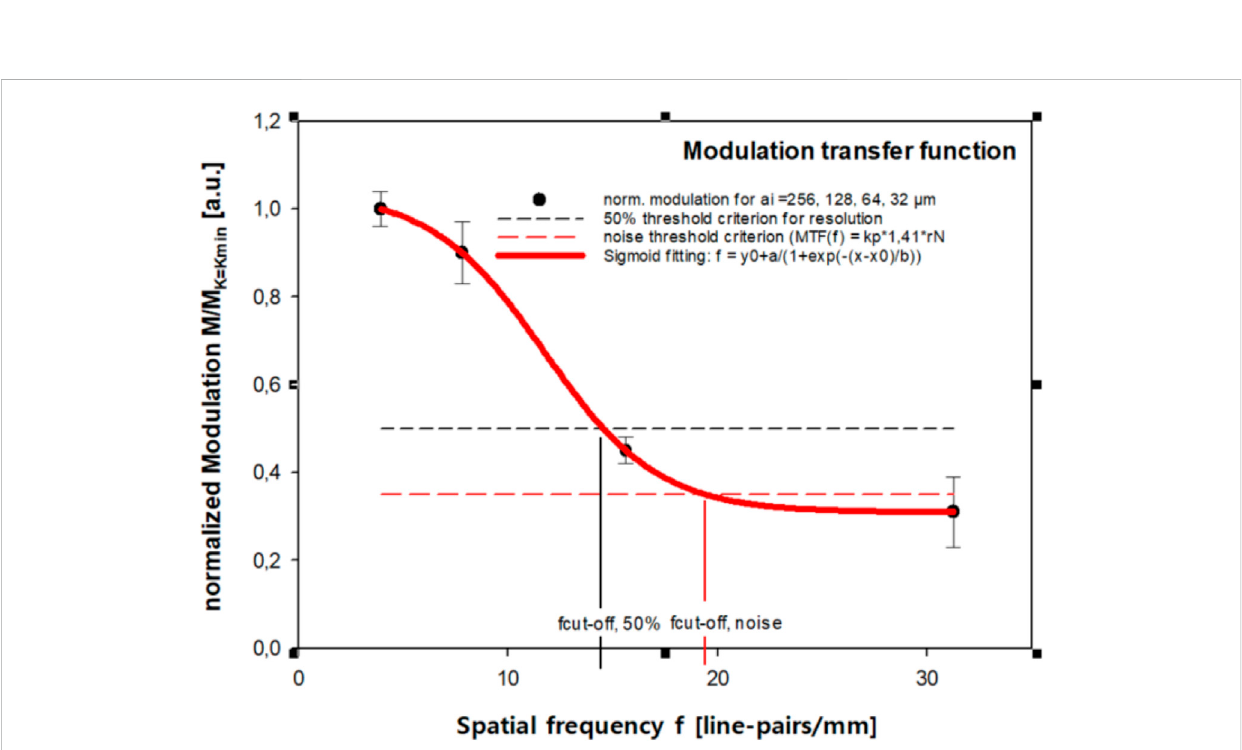
FIGURE 12 Normalized Modulation transfer function (MTF). The modulation of the signal intensity normalized to the signal modulation at lowest spatial frequency M/M K=Kmin (Table 1; Figure 11) is plotted vs. the spatial frequency f. A sigmoidal function (4 parameter fi t) describes the data well and may be used for the evaluation of the cut-off frequency corresponding to the two different resolution criteria by interpolation. The resolution criterion level (50%-MTF level: fcut-off 50% = 14.5 line pairs/mm) is indicated by the dashed horizontal black line. The Modulation-to Noise-criterion (M crit = kp √ 2 σ < I > ; kp = 2) is also shown as red dashed line (f noise / max -I min cut-off_noise = 19.40 line